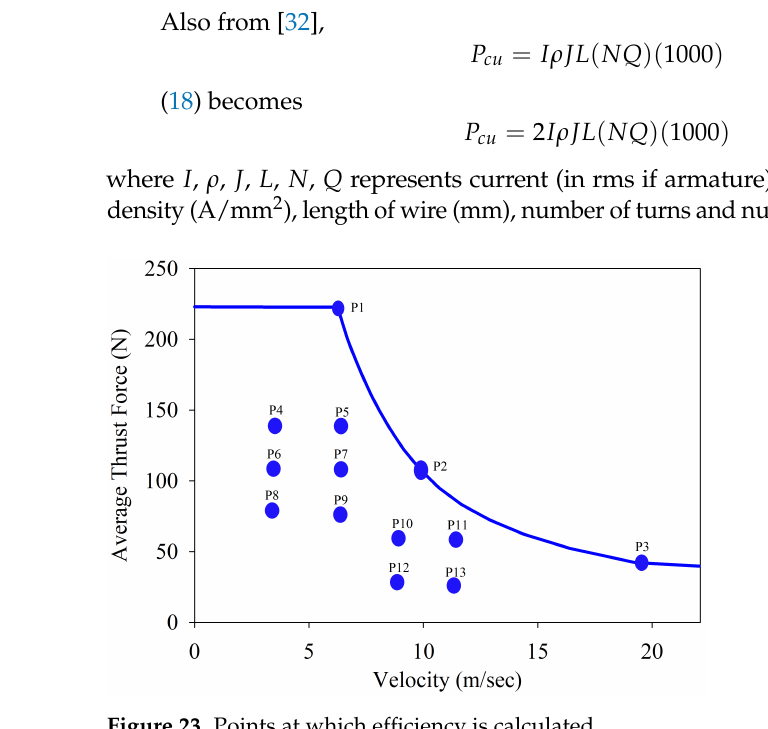
Figure 23. Points at which efficiency is calculated.